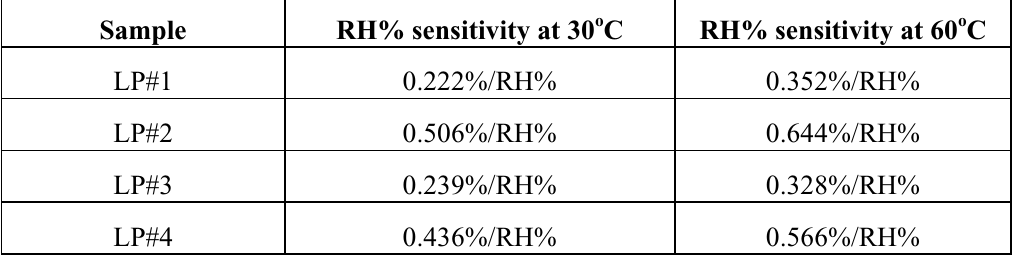
Figure 12. Humidity Sensitivity Curves for In Table 4 . Relative humidity (%) sensitivity of each In sample produced at low pressure, at 30 o C and 60 o